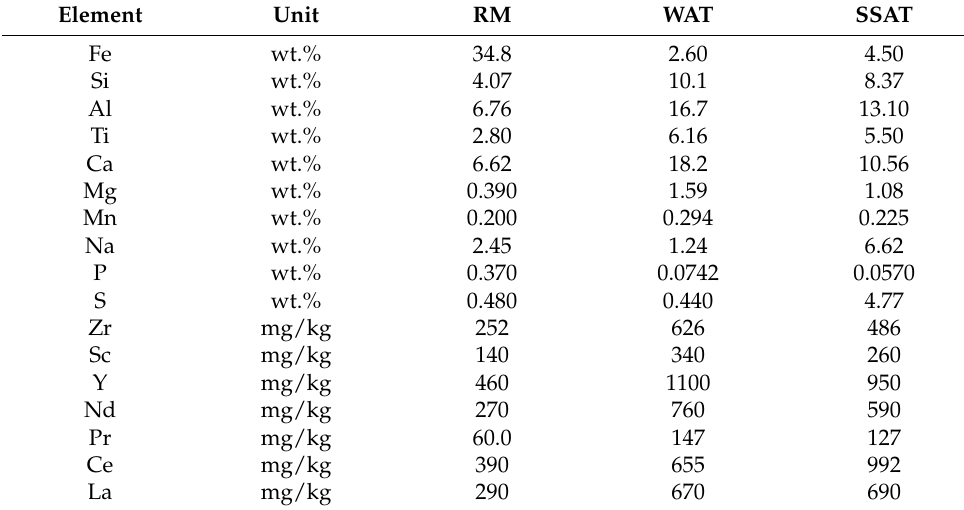
Table 1. Chemical composition of the samples (wt.% or mg/kg).